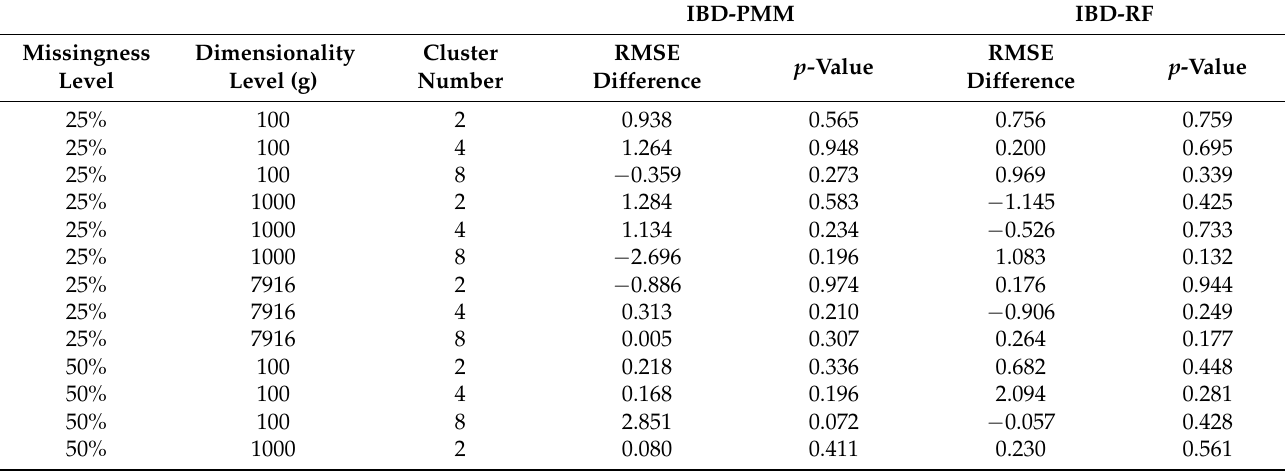
Table A4. The RMSE difference from imputation is applied with and without the integration of comorbidity information for the IBD dataset. Negative RMSE correspond to improvement by the hybrid approach. The pmm and rf models in MICE were used in this study. The p -value is reported based on 10